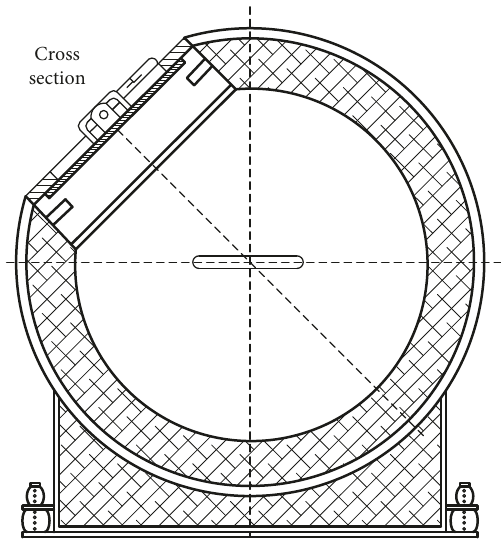
Figure 8: Spherical blast